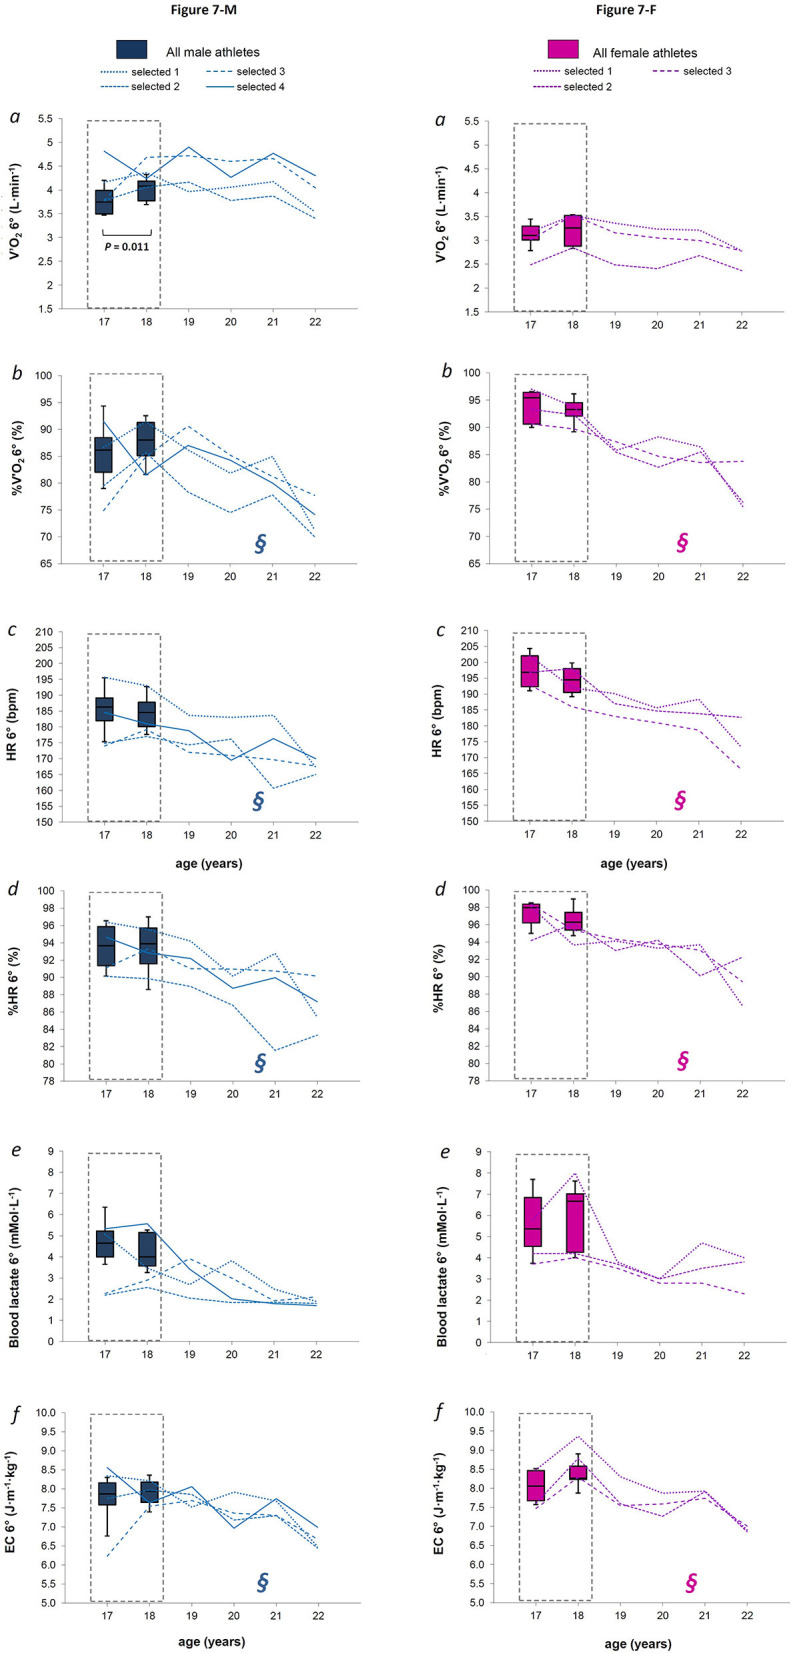
Figures 7-M and 7-F. For males and females (Figures 7-M and 7-F, respectively), the box plot represents medians, 9, 25, 75, and 90th percentiles of the values measured at 6° of treadmill incline (6°) for absolute oxygen consumption (panel a), relative oxygen consumption (panel b), absolute heart rate (panel c), relative heart rate (panel d), blood lactate concentration (panel e), and energetic cost of diagonal skiing (panel f) measured over the late teenage period (data in dotted-lined boxes) in the entire group. The P-value refers to the statistical age effect during the late teenage period. In each panel, the line plots represent each selected athlete from 18 to 22 years of age. § indicates a likely effect of age after the late teenage period.